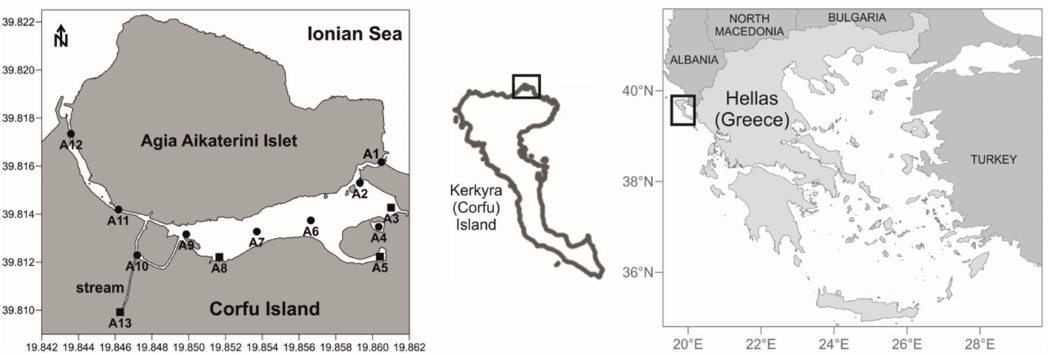
Figure 1. Location of the study area and sampling stations. Rectangles mark groundwater